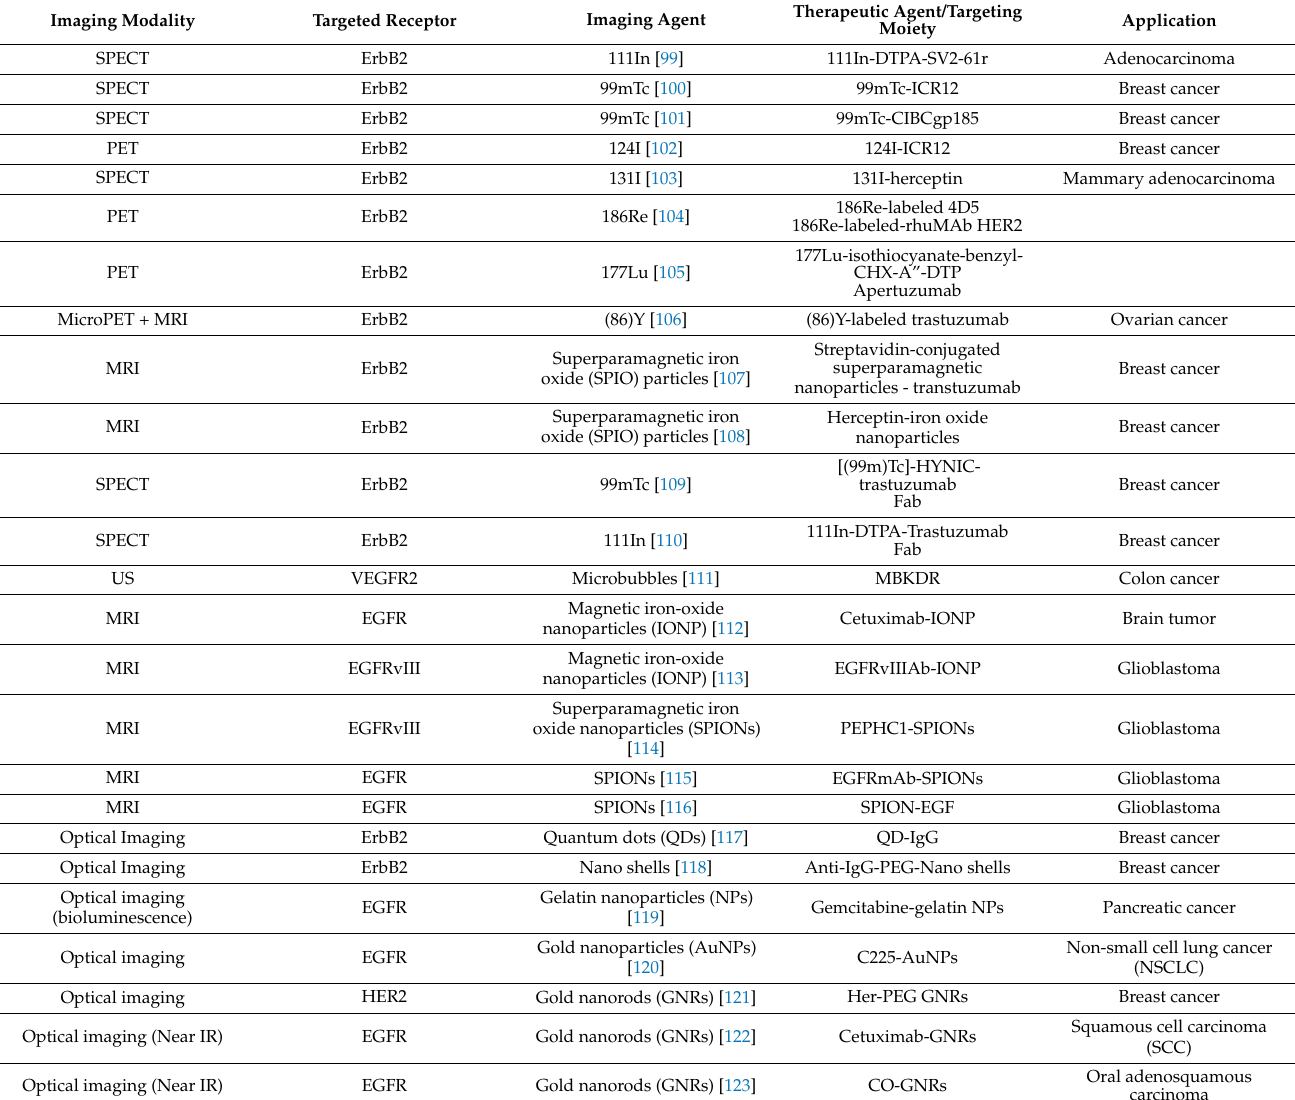
Table 3. Imaging modalities and contrast agents are commonly used for EGFR and VEGFR families of